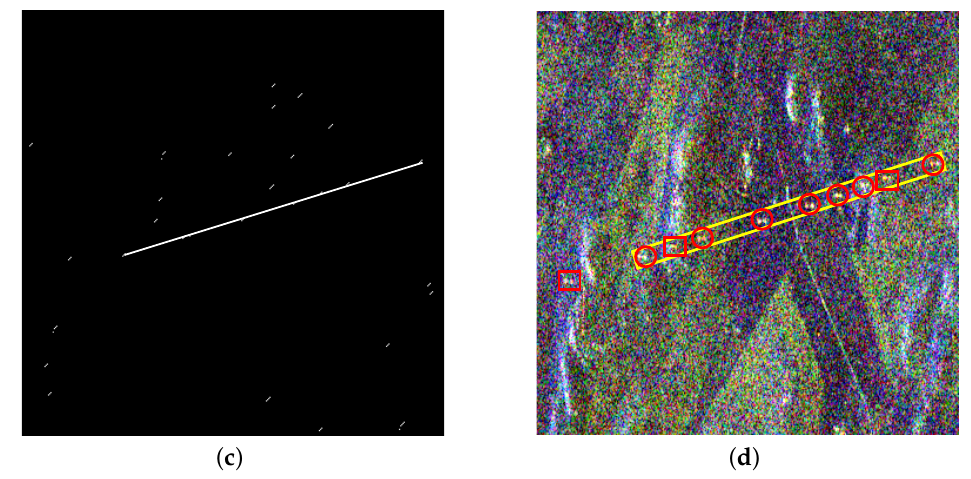
Figure 8. ( a ) filtered image based on PWF; ( b ) point-like target detection results; ( c ) a-contrario extraction result; and ( d ) extraction result marked on the original image.